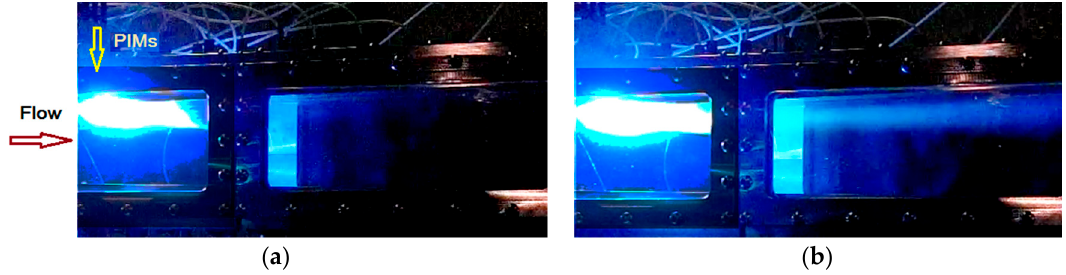
Figure 15. Images of the combustion zone for two cases: ( a ) strong combustion; ( b ) partial fuel oxidation. Flow is from left to right.